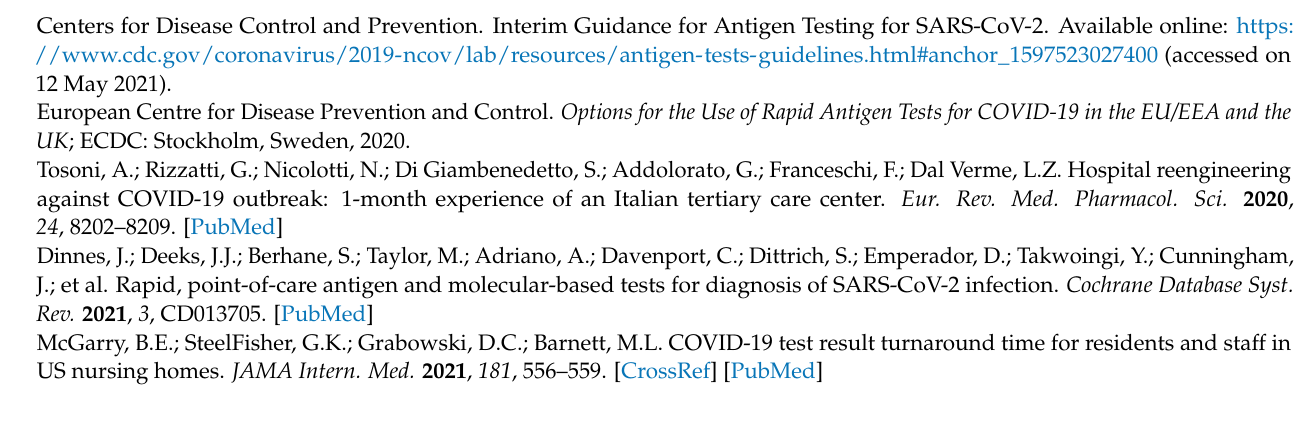
NPV and PPV with their 95% CI at indicated COVID-19 prevalence using the STANDARD F COVID- 19 Ag FIA